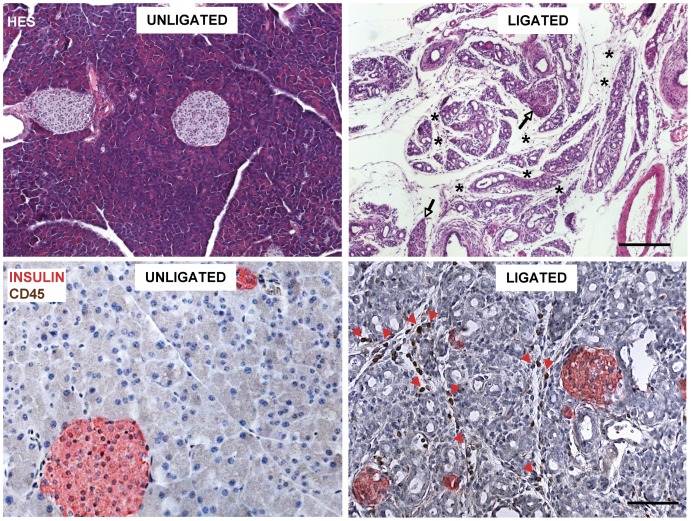
Comparison of tissue composition in unligated (left) and ligated (right) pancreatic tails.Two weeks after duct ligation the tissue is devoid of acini. It mainly consists of ducts with interspersed islets (arrows) and enlarged fibrous septa and adipose tissue (stars). It exhibits an inflammatory infiltration with numerous CD45-positive leucocytes in the septa (red arrowheads); these cells were virtually absent in unligated tissue. The degree of infiltration was less pronounced than after one week. Hematoxylin-eosin, scale bar 200 µm (upper panel) and immunohistochemistry for insulin (red) and CD45 (brown), scale bar 100 µm (lower panel).